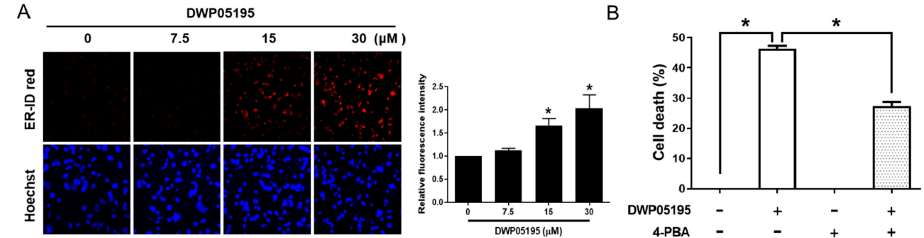
Figure 2. Involvement of endoplasmic reticulum (ER) stress in DWP05195-induced apoptosis. ( A ) A2780 cells were treated with 0, 7.5, 15, and 30 µ M of DWP05195 for 24 h, and then analyzed using a confocal fluorescence microscope. Fluorescence intensity was analyzed with the ImageJ software.